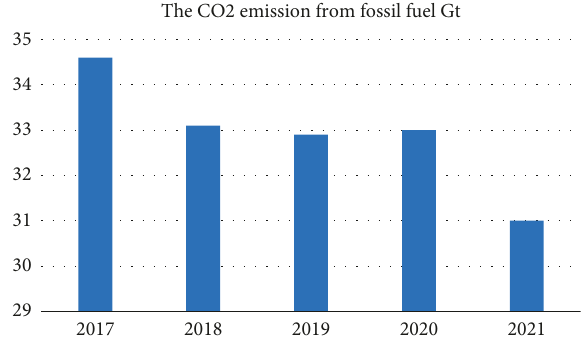
Figure 1: The CO 2 emission from fossil fuel.